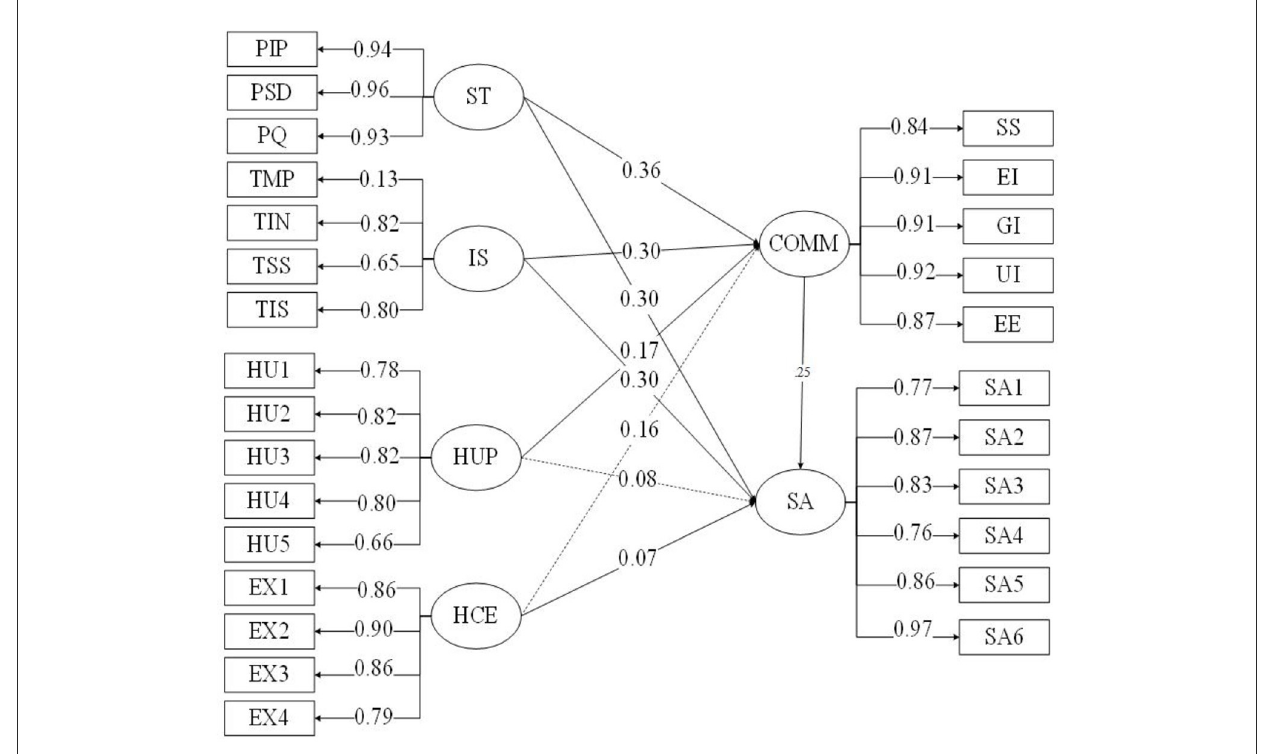
FIGURE2 Structural equation model of patient